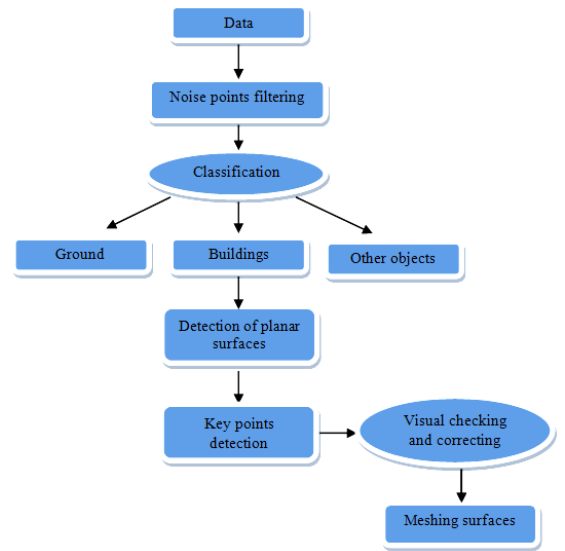
Figure 3. The procedure applied in geometry